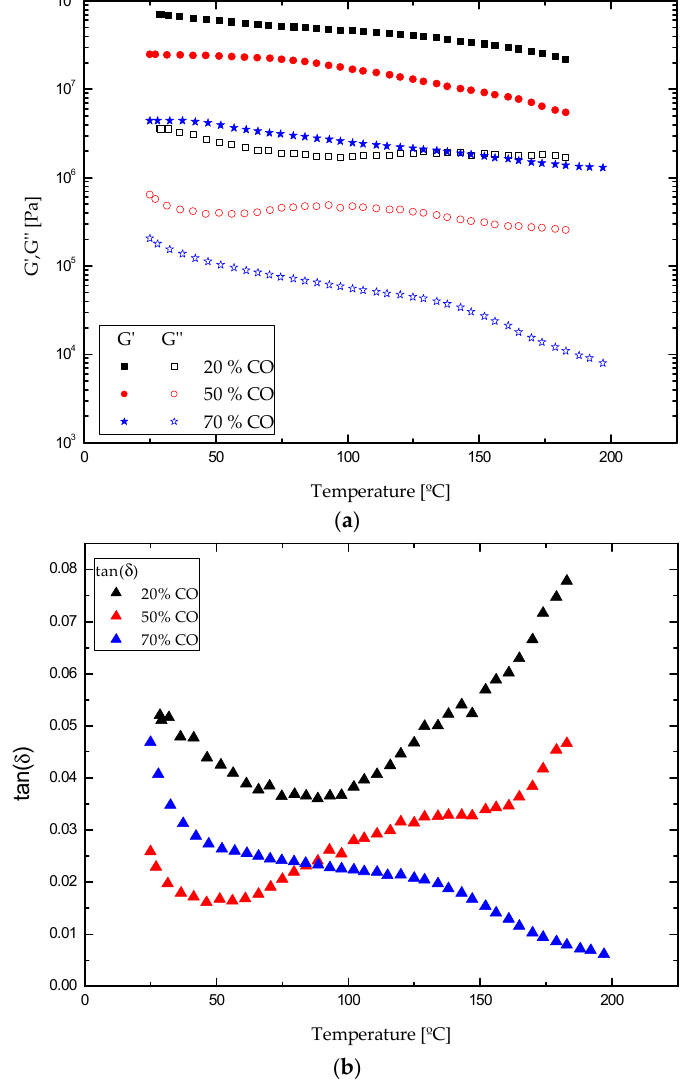
Figure 8. Temperature ramps for all ecofriendly bioadhesives at 2 °C/min of heating rate within the linear viscoelastic region: ( a ) elastic ( G ′ ) and viscous ( G ″ ) moduli; ( b ) loss tangent (tan δ ).